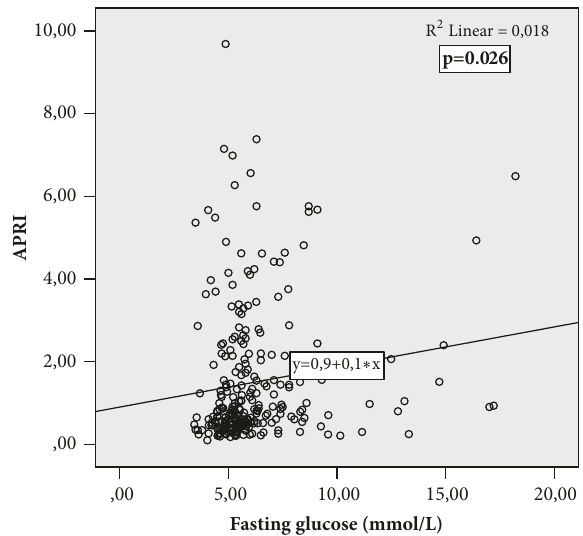
Figure 1: Correlation between fasting glycemia and APRI noninva- sive score of